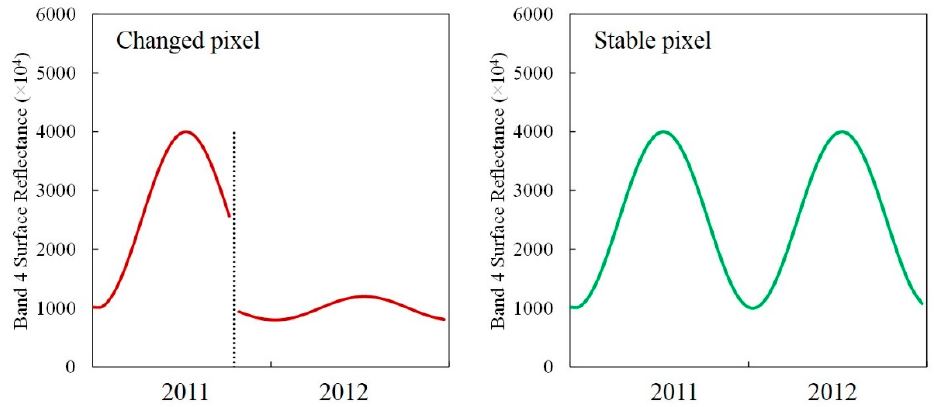
Figure 3. Illustration of changed and stable pixels detected by CCD. The time-series models shown are based on Landsat band 4 data. The left-hand panel illustrates the signal for a changed pixel, and the vertical black dotted line represents the change that occurred in 2011. This pixel was labeled as “disturbed” in the land-cover map for 2011. The right-hand panel illustrates the signal of a stable pixel; the percentile features for this land-cover type were derived from time-series data such as these.